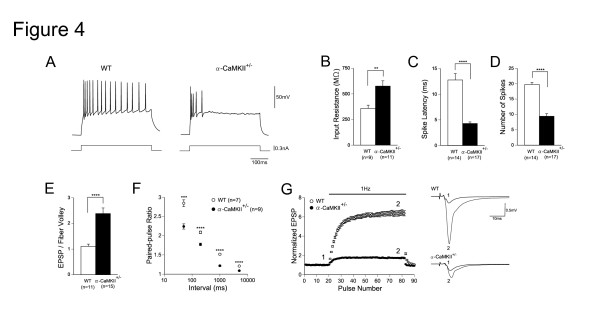
Altered Granule Cell Excitability and Mossy Fiber Synaptic Transmission in Alpha-CaMKII+/- Mice. (A) Examples of action potential firing of granule cells in wild-type and mutant mice evoked by steady depolarizing currents (320 pA, 400 ms). (B) Increased input resistance in mutant mice (P = 0.0029). (C) Reduced spike latency in mutant mice (P < 0.0001). Depolarizing currents (320 pA) were injected into granule cells and the latency of the first action potential was measured. (D) The maximal number of spikes evoked by 400 ms depolarizing currents was decreased in mutant mice (P < 0.0001). (E) The efficacy of basal transmission at the mossy fiber synapse was increased in mutant mice (P < 0.0001). The ratio of the peak EPSP amplitude to fiber volley amplitude is shown. (F) Reduced paired-pulse facilitation ratios of EPSPs at intervals ranging from 50 to 5000 ms in mutant mice. (G) Mutant mice had greatly reduced frequency facilitation at 1 Hz. Sample EPSPs were recorded at the time indicated by the numbers in the graph. Error bars indicate s.e.m.